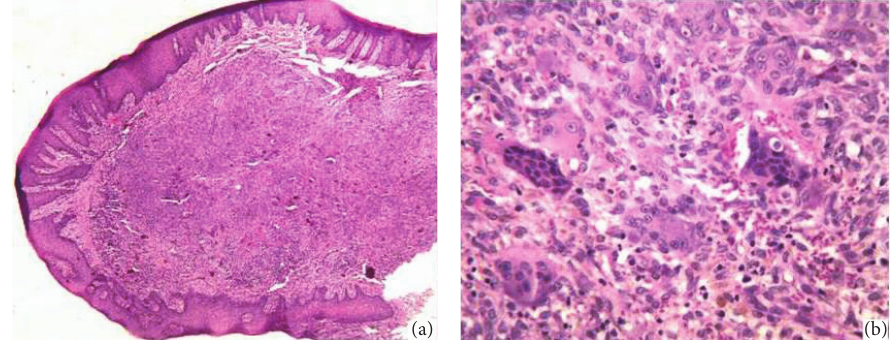
Figure 4: (a) Low magnification of PGCG. The stratified squamous epithelium exhibits hyperkeratosis and acanthosis. The subjacent fibrous connective tissue showed noncapsulated nodular proliferation of cellular mesenchymal tissue with abundant multinucleated giant cells dispersedthroughout(H&E;originalmagnification × 20).(b)HighermagnificationofPGCGshowinggiantcells,spindle-shapedovoidplump stromal cells, inflammatory cells, capillaries, hemorrhage, and hemosiderophages (H&E; original magnification × 400).